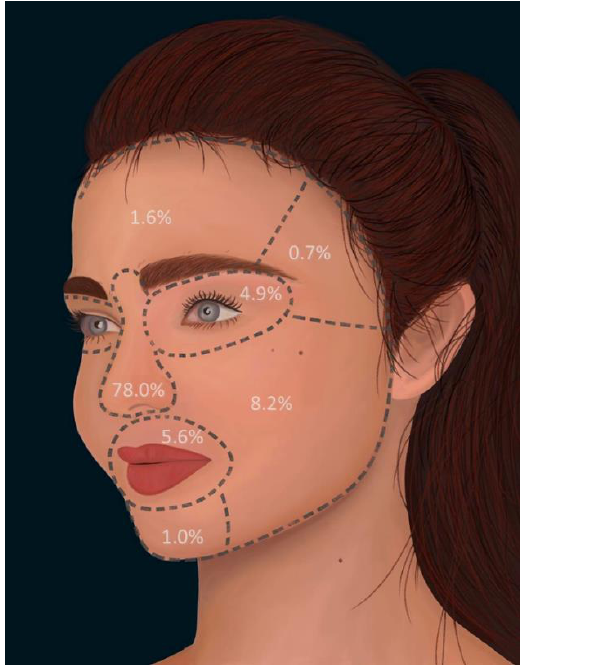
a b Figure 1. Distribution of flaps and full thickness skin graft (FTSG) according to distinct facial units. ( a ) Distribution of flaps according to the facial region. ( b ) Distribution of FTSG by the facial regions. The most frequent site of surgery was the nasal region, ( n = 363, 59.8%), where the Table 3. Variety of utilized